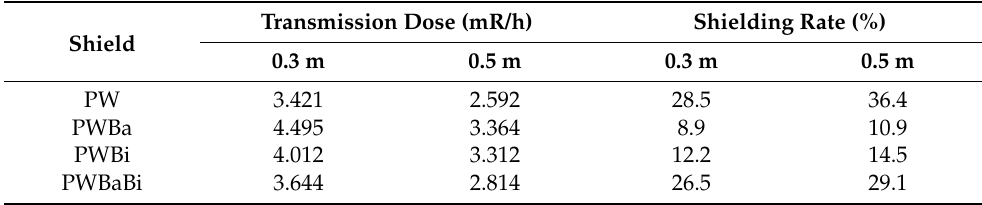
Table 3. Transmission dose and shielding rate of 131 I.